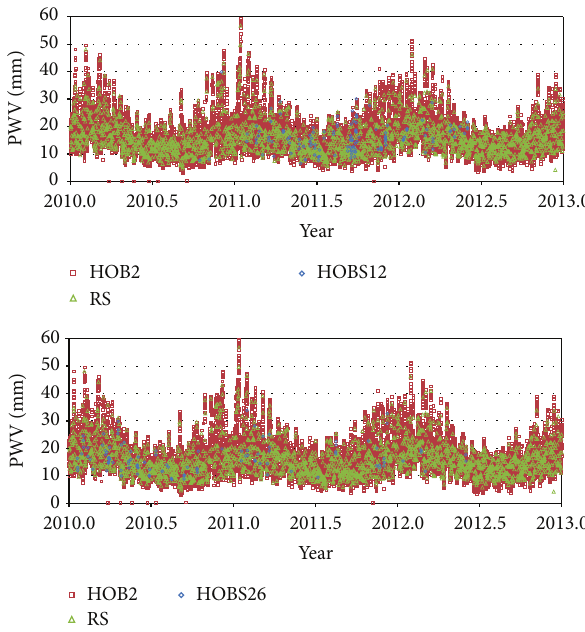
Figure 2: PWV time series at colocated GPS (square) and VLBI (diamond)sitesinHobart,Australia.Aradiosondestation(triangle) is also present in Hobart Airport located approximately 7 km away from the Hobart geodetic site.